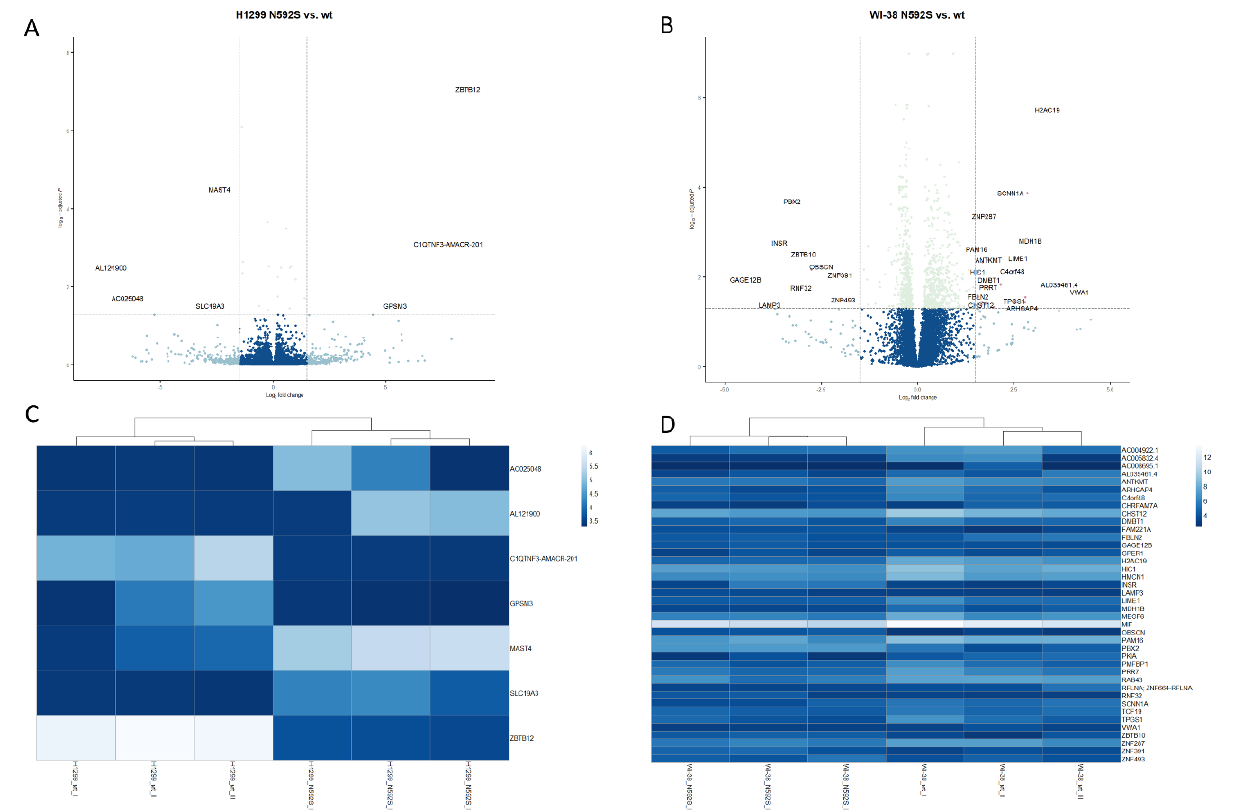
Figure 6. Comprehensive transcriptome analysis of the H1299 and WI-38 cell lines overexpressing TLR5 WT or TLR5 N592S gene variants. Volcano plot of differentially expressed transcripts in H122 ( A ) and WI-38 ( B ) cell line. Heat map describing expression of statistically significant DEGs with dendograms indicating hierarchical clustering between H1299 ( C ) and WI-38 ( D ) cell lines. The application of the DESeq2 analysis identified 6 differentially expressed genes in H1299 cell line (log2-fold change ≥ 1.5 and ≤− 1.5, adjusted p -value < 0.05), 3 of